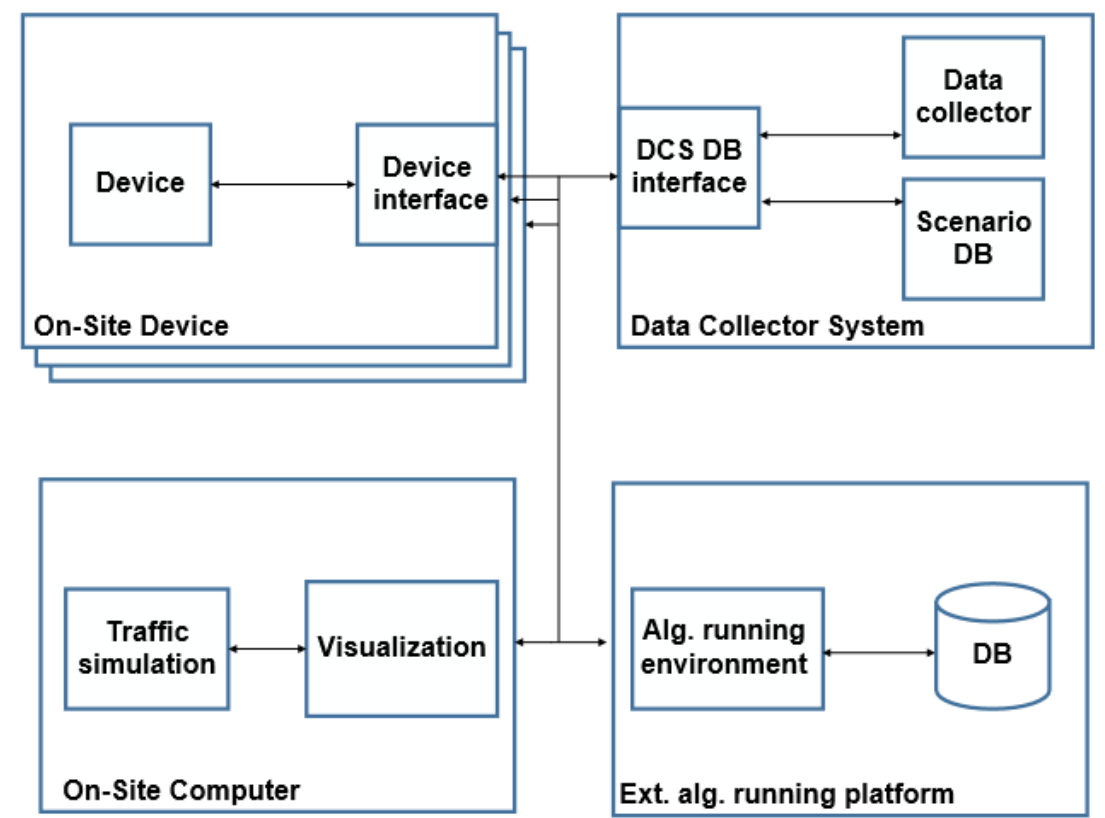
Figure 6. High-level architecture of the communicating systems and their